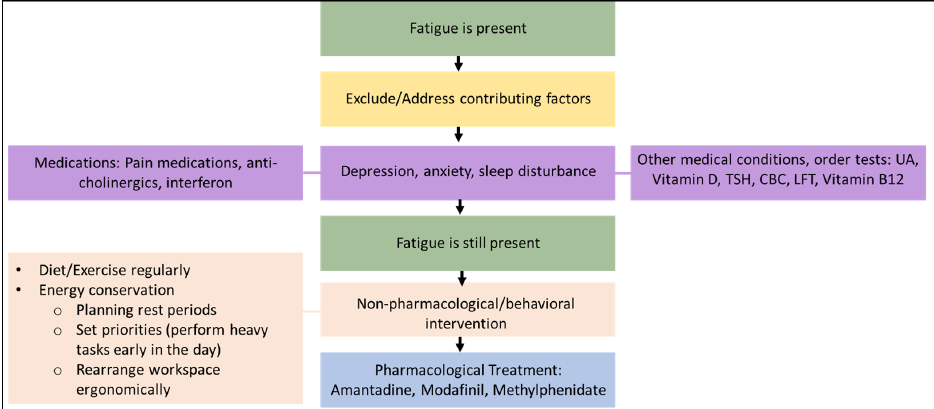
Figure 1. Management of fatigue in people with MS.